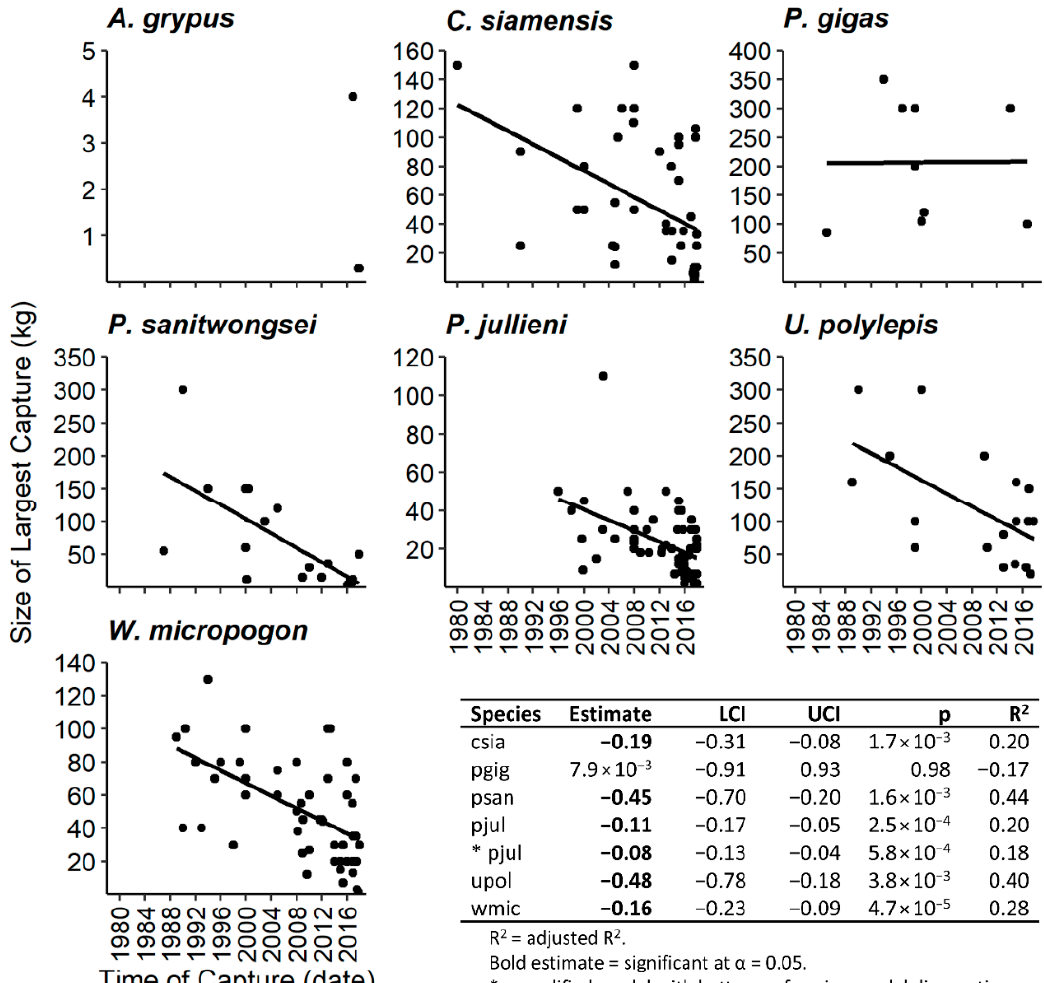
Figure 5. Plots of the size and date of capture of the largest Mekong megafish specimens reported by fishers. Trend lines represent the result of a simple linear regression of body weight and time. The table summarizes regression statistics for the simple linear regression models. ( Aaptosyax grypus was excluded from the table because its sample size was too small to model the relationship between body weight and time). Model diagnostics were run and found to be acceptable for all species with these exceptions: Pangasianodon gigas had non-normal residuals; Pangasius sanitwongsei had heteroscedastic residuals; Probarbus jullieni had non-normal and heteroscedastic residuals and an influential outlier. A second model was run for Probarbus jullieni without the outlier (* pjul), and the model diagnostics were only slightly improved. Sample sizes for each species are the total numbers of high-quality interviews reported for the whole study area in Table 2. Note that all plots have the same x-axis, but different y-axes.